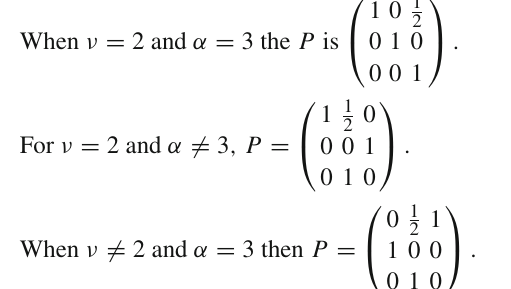
Table 9 C 4 (reduced system)